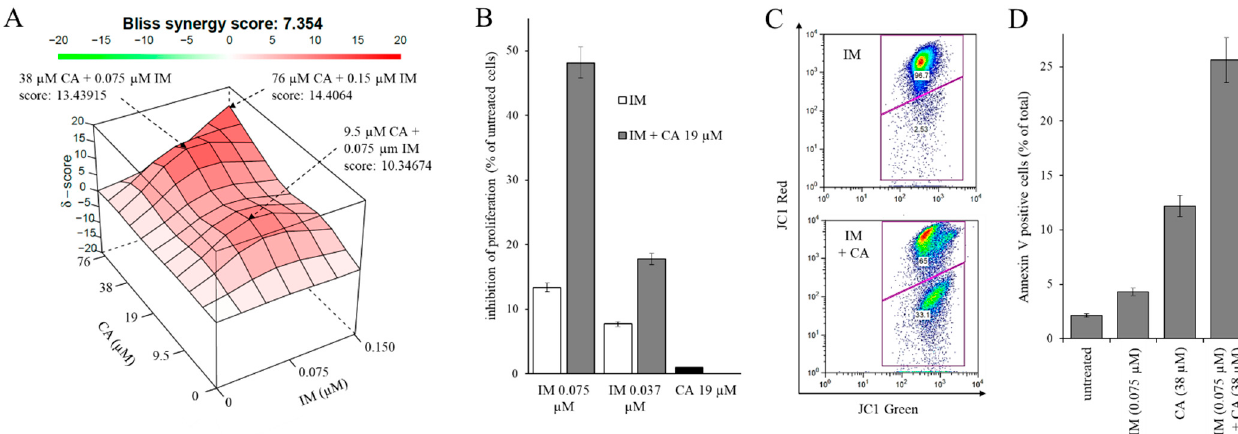
Figure 4. Synergistic effect of caffeic acid (CA) and imatinib mesylate (IM) on cell proliferation and on triggering apoptosis in K562 cells. ( A ) Calculation of the synergy scores. The indicated Bliss synergy score is the average of the values obtained for all the concentration combinations tested. The three-dimensional (3D) synergy maps highlight synergistic (in red) and antagonistic (in green) dose regions. The drug combinations with the most marked synergy scores have been indicated by the arrows. ( B ) Effect of combined treatment with suboptimal IM and CA concentrations on cell proliferation. Data are expressed as mean value plus standard deviation of three experiments performed in duplicate. ( C ) A representative analysis of the mitochondrial membrane potential was performed by JC-1 staining on cells treated for two days with 0.075 µM IM in the presence or absence of 38 µM CA. ( D ) Analysis of phosphatidylserine extroversion of cells treated with IM in the presence or absence of CA for three days. The results were expressed as arithmetic mean ± standard deviation. Cells were stained with Annexin V/PI.